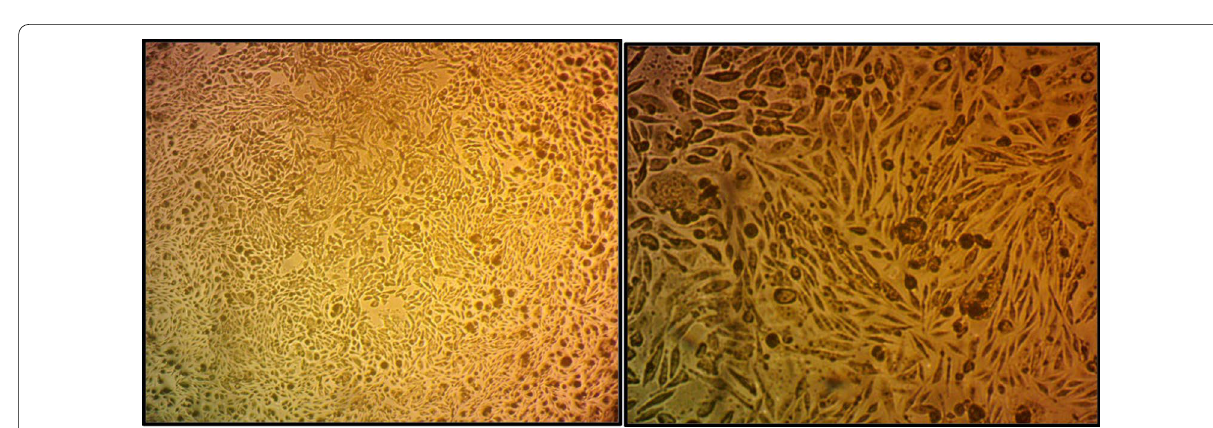
Fig. 5 Photomicrograph of control HNO97 cells cultured in routine culture media (